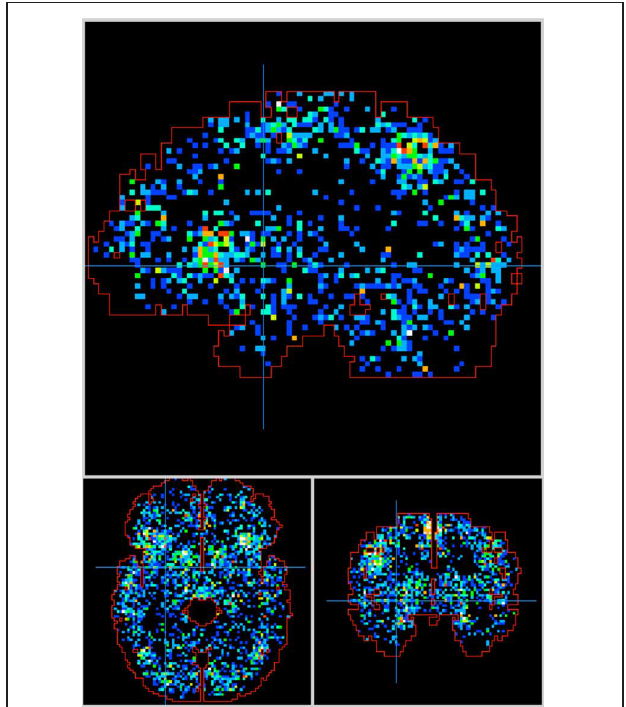
FIGURE 4 | Activation foci from all 51 behavior sub-domains are distributed throughoutthe Talairach brain. Outline from the Talairach Daemon. Crosshair at ( − 28, 0,